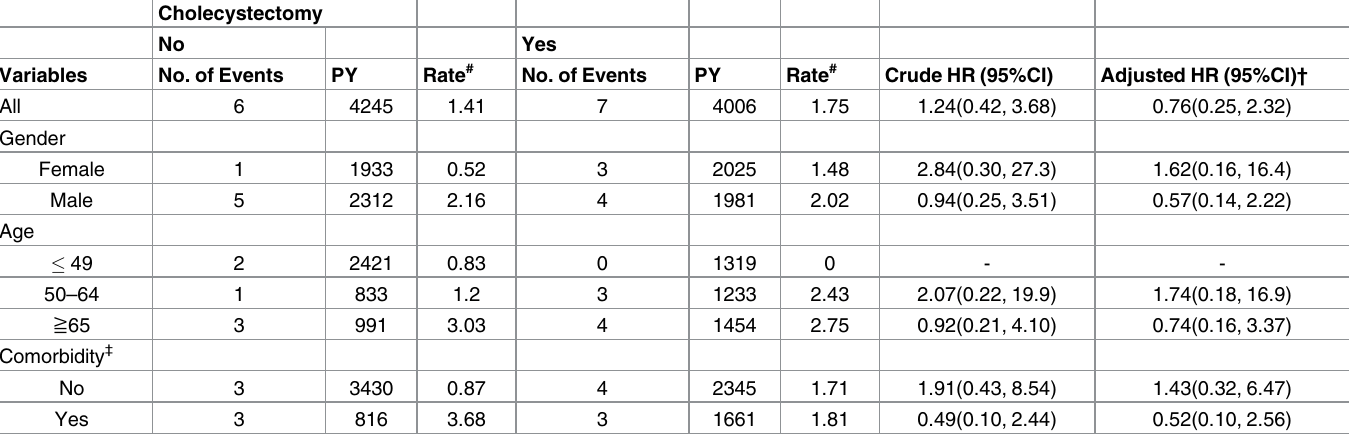
Table 2. Incidence and adjusted hazard ratio of colorectal cancer stratified by sex, age and comorbidity compared among inflammatory bowel dis- ease patients with cholecystectomy and without cholecystectomy. Cholecystectomy